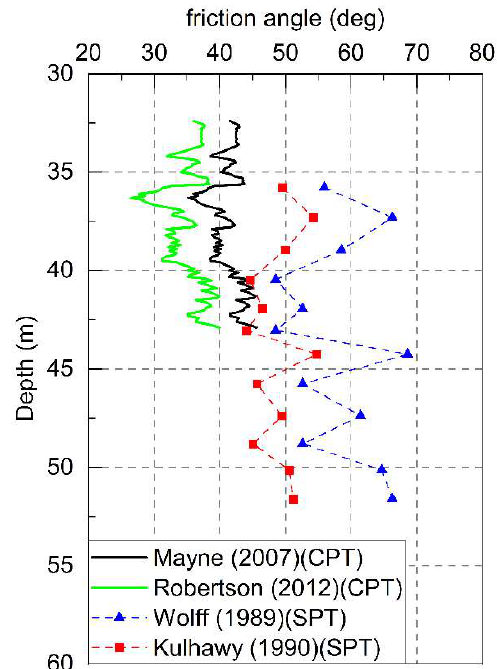
Figure 7. Soil classification of CW gneiss based on CPT data from 32.3 m to 42.9 m.